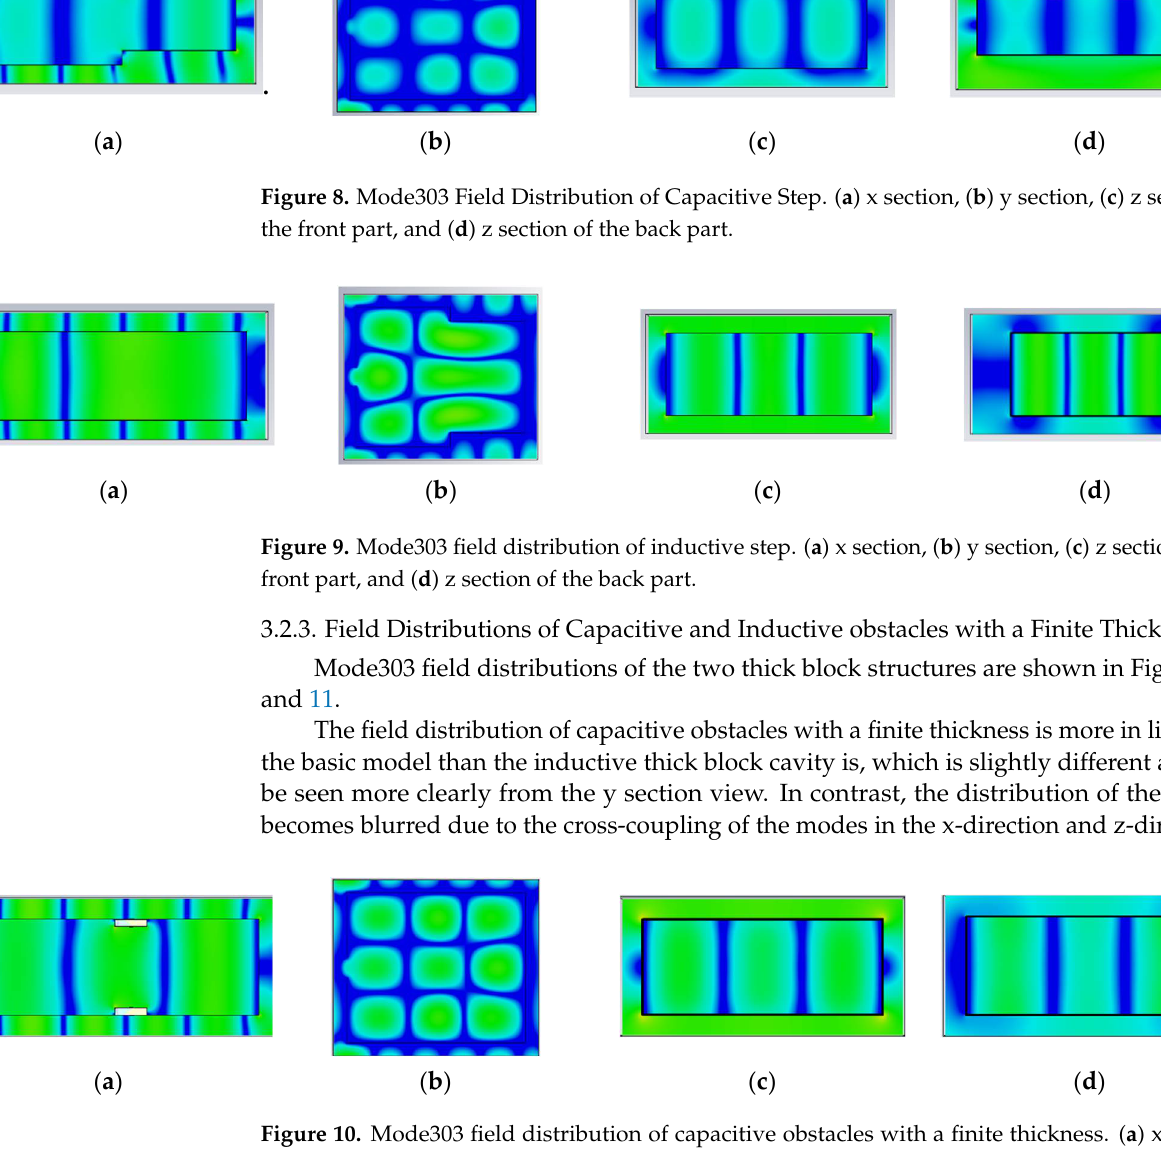
Figure 11. Mode303 field distribution of inductive obstacles with a finite thickness. ( a ) x section, ( b ) y section, ( c ) z section of the front part, and ( d ) z section of the back part. 3.2.4. Field Distributions of Capacitive and Inductive Obstacles with Zero Thickness